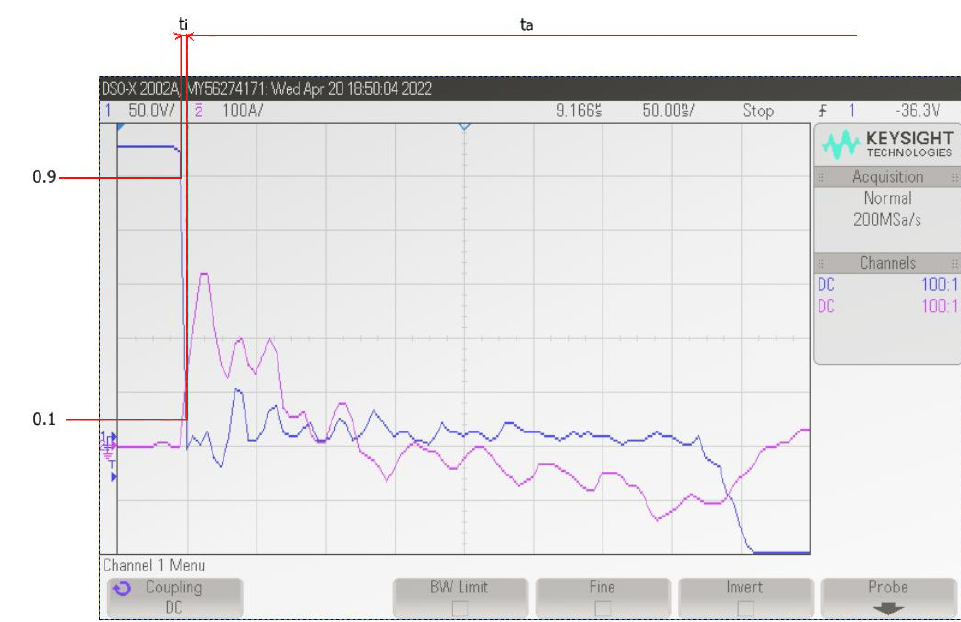
Figure 4. Measured method of ignition the arc (parameters: 50 V/div, 100 A/div, 50 ns/div).